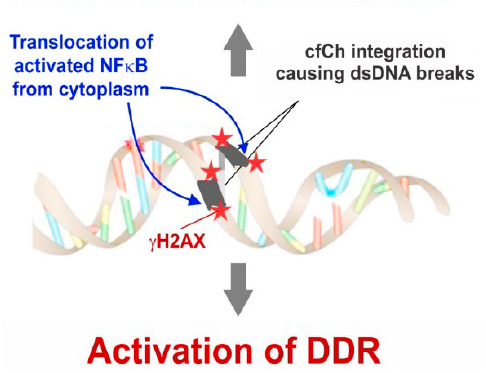
Figure 12. Schematic representation of a proposed model to explain detection of co-localized fluorescent signals of γ H2AX and NF κ B. Reproduced with modification from [96].